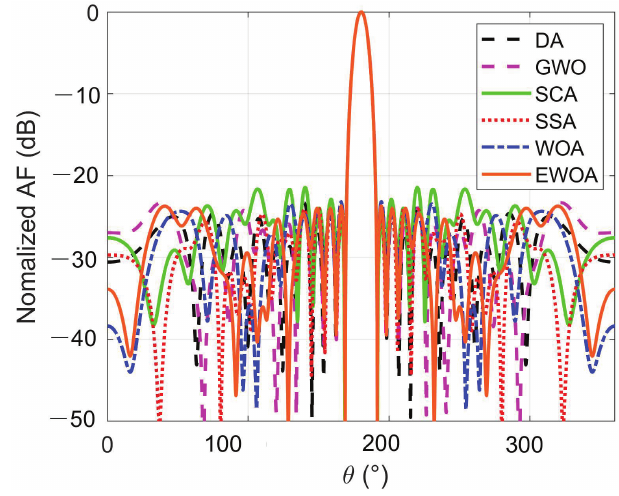
Figure 3. Beam patterns obtained by different algorithms.